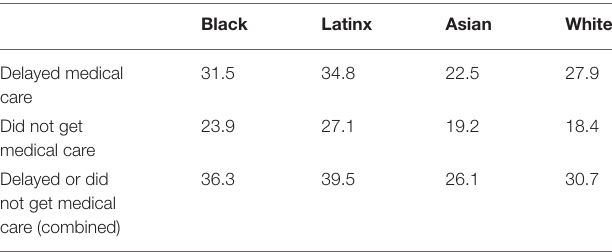
TABLE 7 | Adults ages 65 and over who delayed or did not get needed medical care past 4-weeks due to COVID-19 pandemic,